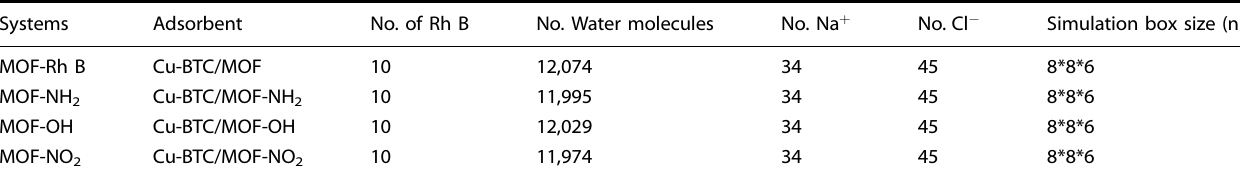
Table 2. The different MOFs/dye systems used in our